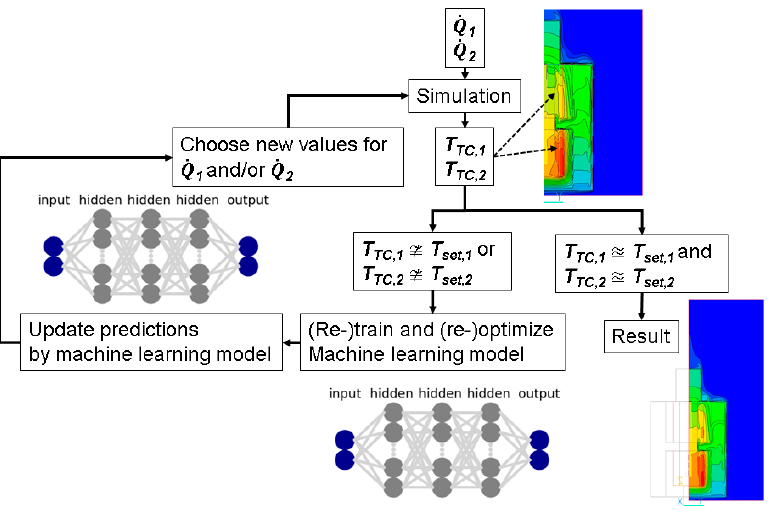
Figure 2. Workflow using for machine-learning assisted power adjustment in simulations.